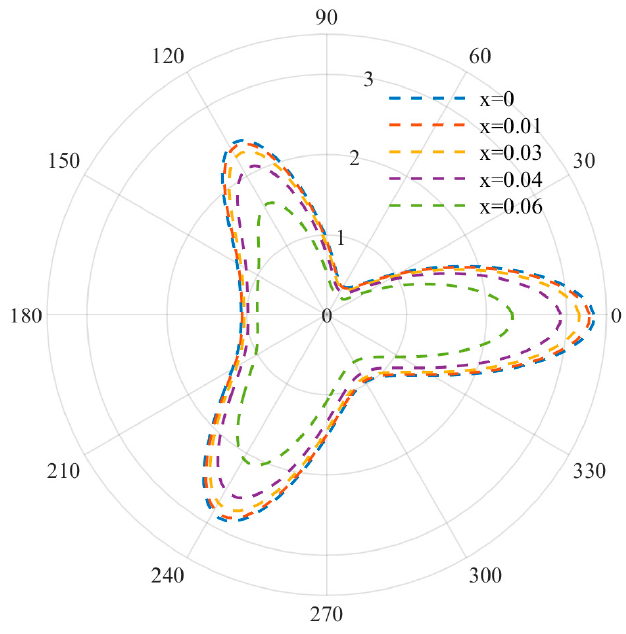
Figure 3. Distribution diagram of DSCD ( ka = 0.8).